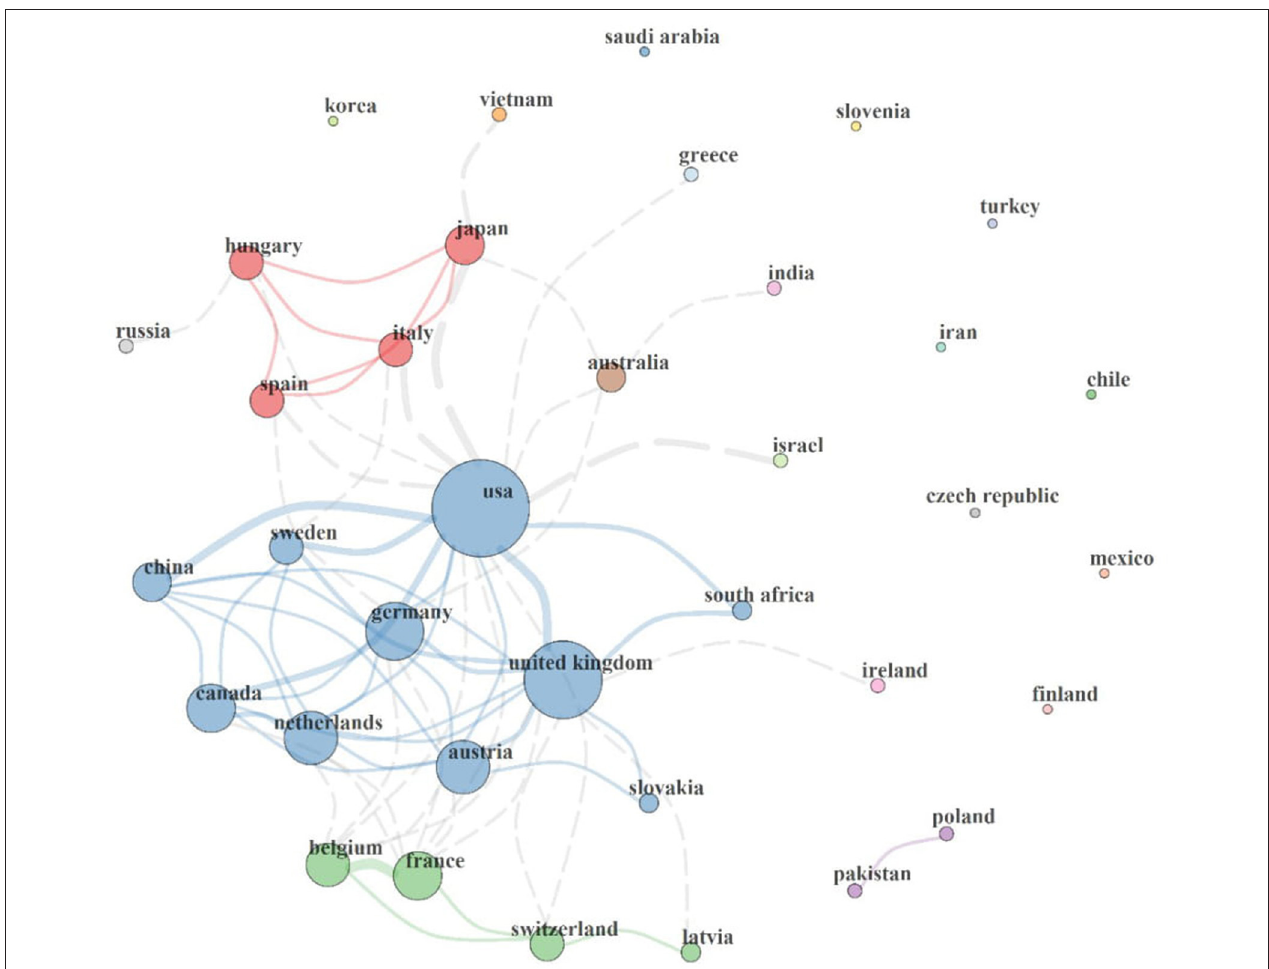
FIGURE 3 | Country collaboration map in MPP-AD research. Network statistics: Size = 36, Density = 0.11, Transitivity = 0.535, Diameter = 4, Degree Centralisation = 0.405, Closeness Centralisation = 0.04, Betweenness Centralisation = 0.23, Eigenvector Centralisation = 0.767, Average path length =